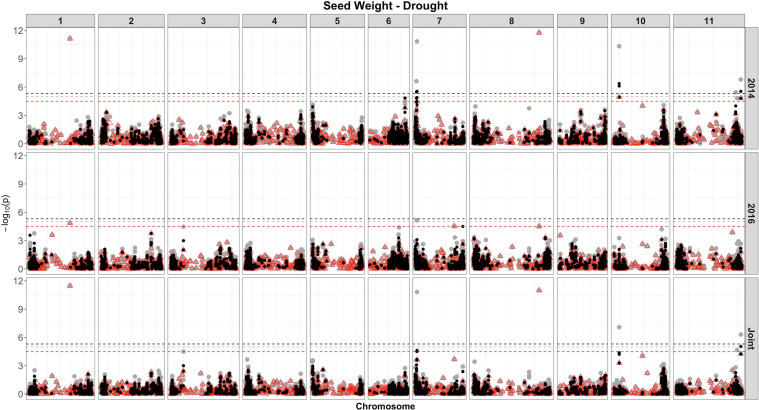
Manhattan plot of the associations for SW for common bean, under drought, using a single-based GWAS (gray circle), segment-based GWAS (red triangle), and gene-based GWAS (black circle) based on the role set of experimental data. Gray, red, and black lines indicate Bonferroni-corrected threshold with an experimental type I error rate at α = 0.05.